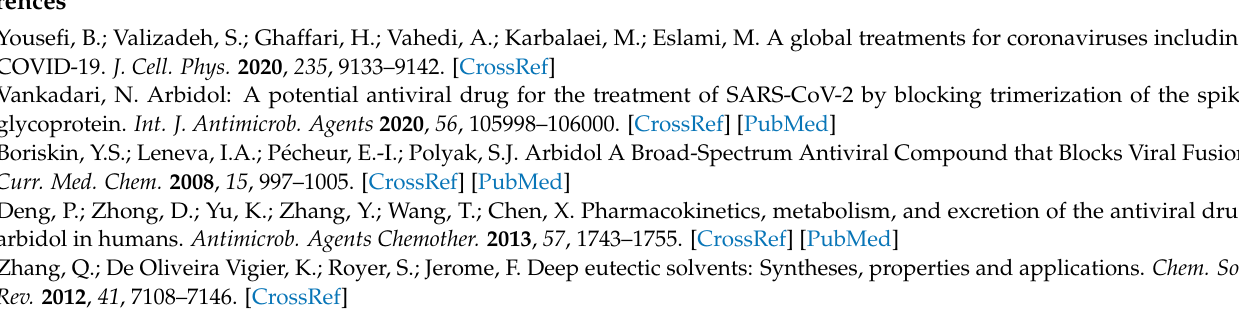
Table S1. The EDS element content of PS-CH 2 Cl (a) and the immobilized-HBA (b); Table S2. The melting point of choline chloride, arbidol and choline chloride-arbidol; Table S3. The ionization degree of arbidol at different pH values; Table S4. Kinetic parameters for the adsorption of arbidol by the immobilized-HBA at 20 ◦ C and pH = 5.5; Figure S1. The Energy dispersive X-ray energy spectrum Figure S3. FT-IR spectra of PS-CH 2 Cl (a) and the immobilized-HBA; Figure S4.TGA curves of PS- CH 2 Cl (a) and the immobilized-HBA; Figure S5. Mid-IR spectra (a) and Far-IR spectra (b) of choline chloride (1), choline chloride-arbidol (2), and arbidol (3); Figure S6. Influence of temperature on